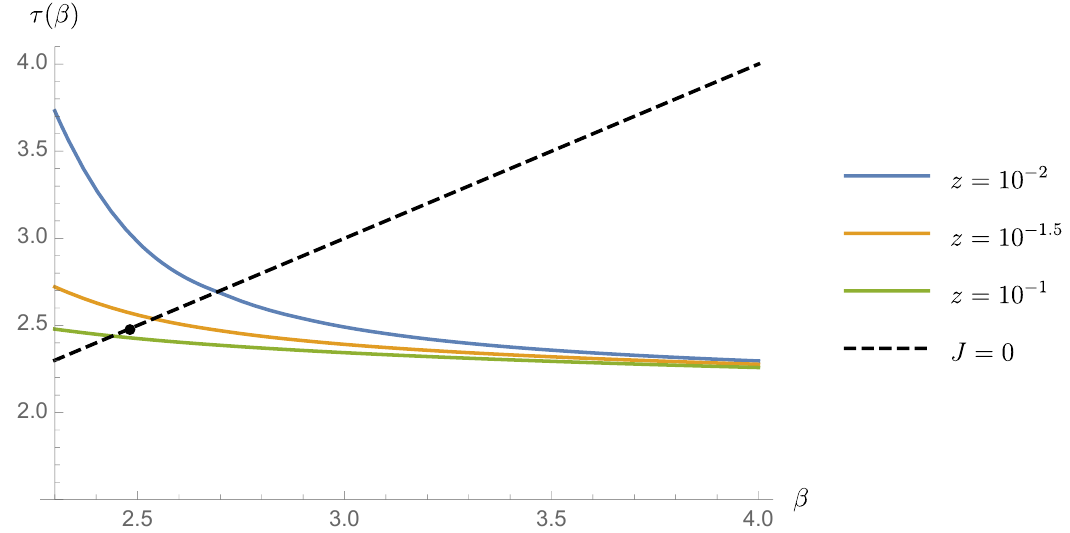
Figure 20 . The intersection between the three curves τ ( β ) and the line J = 0 is the predicted location of the spin 0 operator. The black dot on the J = 0 line is the actual location of shadow of σ operator.